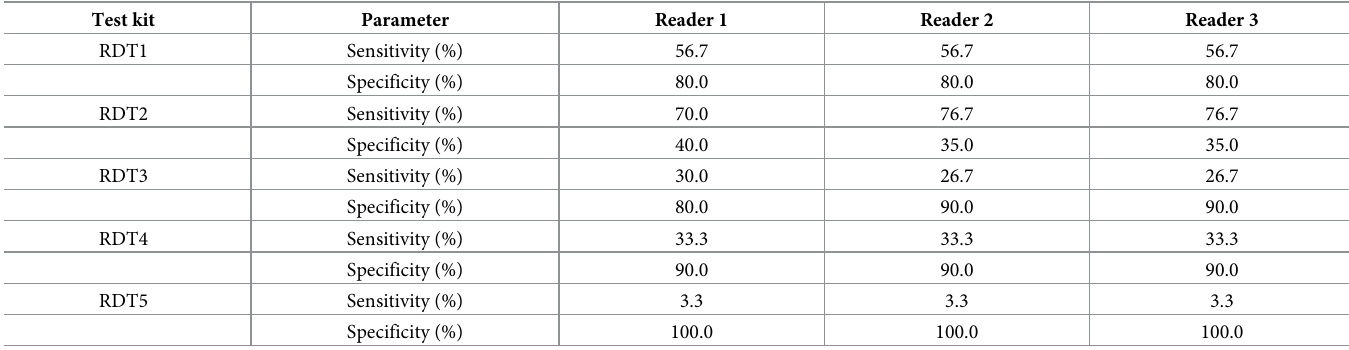
Table 3. Inter-observer